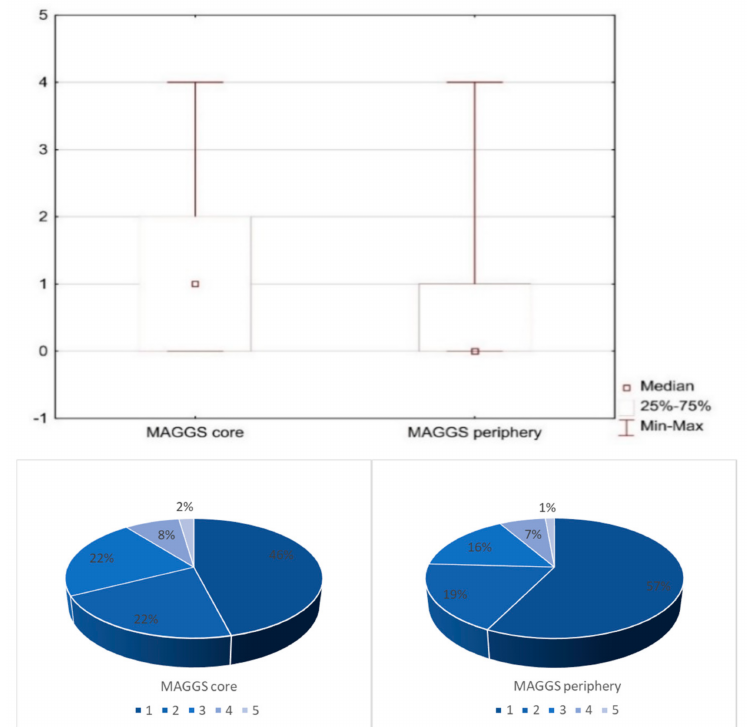
Figure 5. Di ff erence in frequency of using the public bike system in the core and in the periphery of MAGGS. Source: Author’s own elaboration. Notes: The answers of the respondents were transformed on a ordinal numerical scale (0–4), where “never” = 0; “several times a year” = 1; “several times a month” = 2; “several times a week” = 3; and “it’s my daily mode of transportation” = 4. The Mann–Whitney test rejected the hypothesis about the equal median in both groups at the 5% significance level.